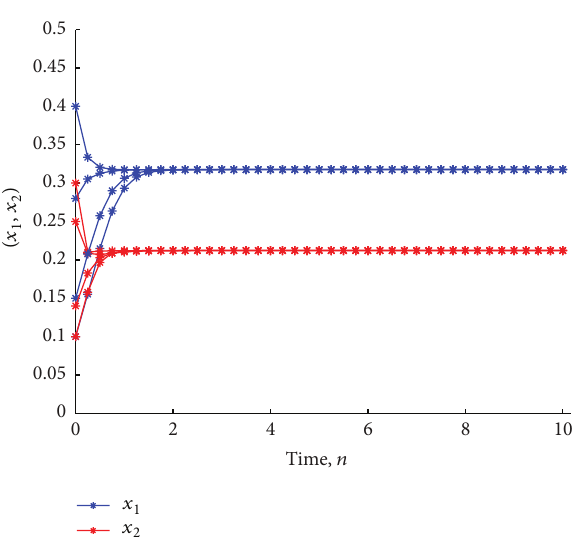
Figure 1: Dynamic behaviors of the solution (𝑥 1 (𝑡),𝑥 2 (𝑡)) of sys- tem (59), with the initial conditions (𝑥 1 (0),𝑥 2 (0)) = (0.1, 0.25) , (0.28, 0.3), (0.15, 0.14) , and (0.4, 0.1) ,